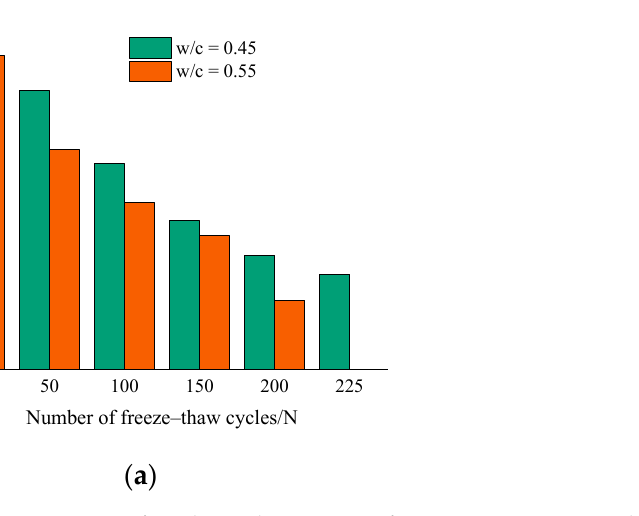
Figure 14. Variation of mechanical properties of concrete specimens under frost damage. ( a ) Flexural strength, ( b ) splitting